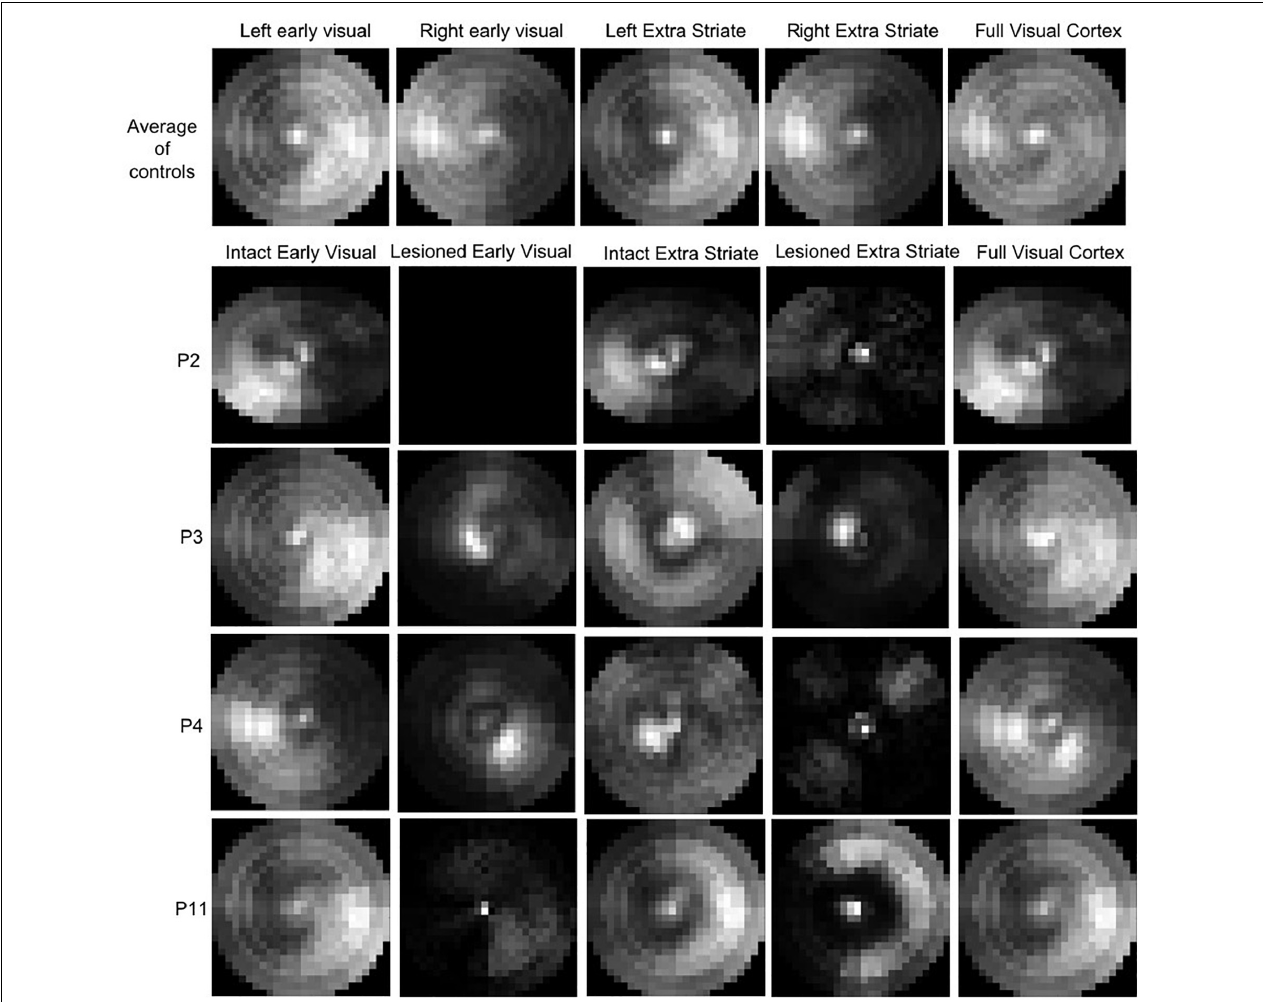
FIGURE 9 | Coverage Maps for early (V1/V2) and extrastriate cortical regions averaged across the control (top row). The brighter the map, the higher the sampling density. P2, who is blindsight negative, shows very little contribution to the VF sampling by voxels in either early or extrastriate ROIs. P11, also blindsight negative, shows some contributing voxels in the sighted hemifield, but few in the blind